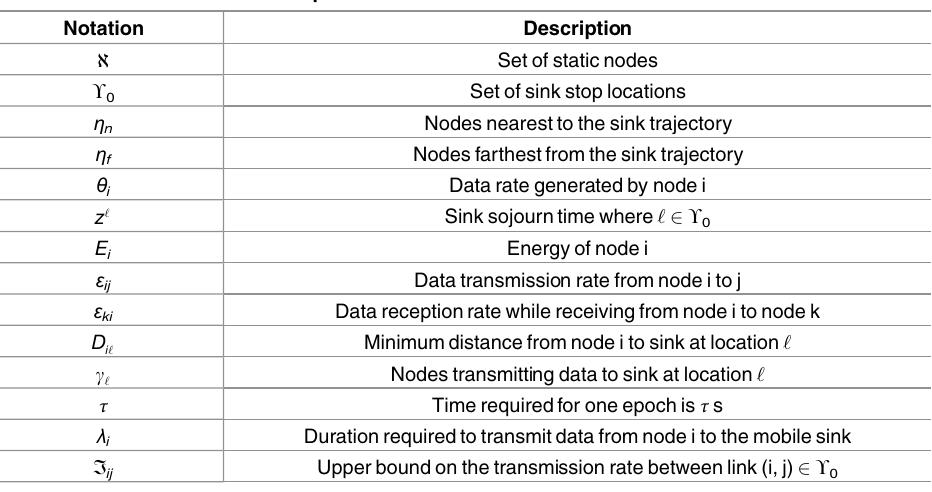
Table 2. Notationsand